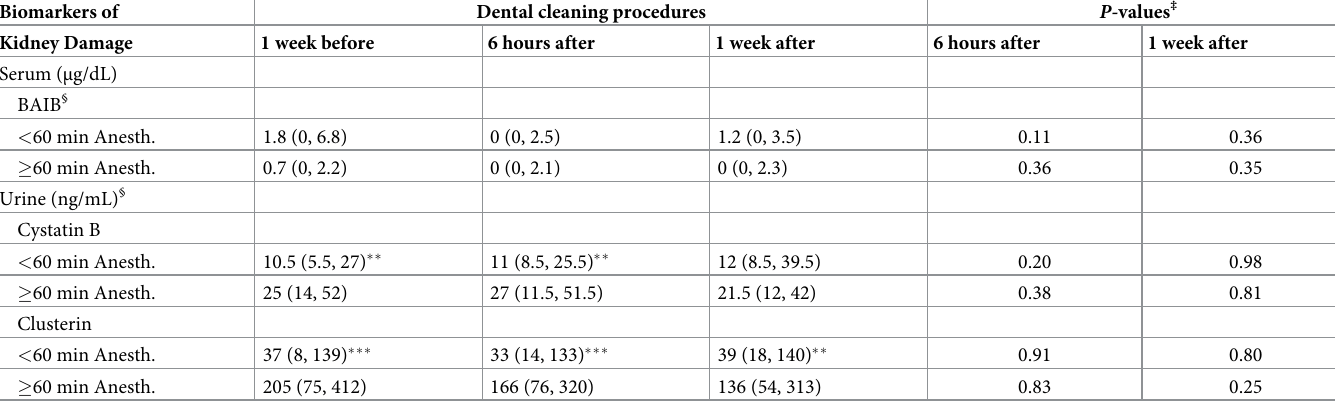
Table 9. Serum and urine kidney tissue damage biomarkers before and after general anesthesia and dental cleaning procedures in cats and dogs with periodontal disease stratified by length of anesthesia (n = 62) � . Biomarkers of Dental cleaning